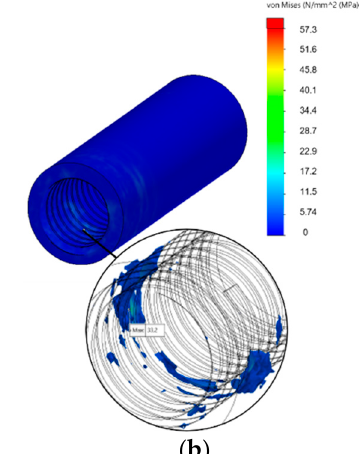
Figure 15. Distribution of von Mises stress for the instrumented device.